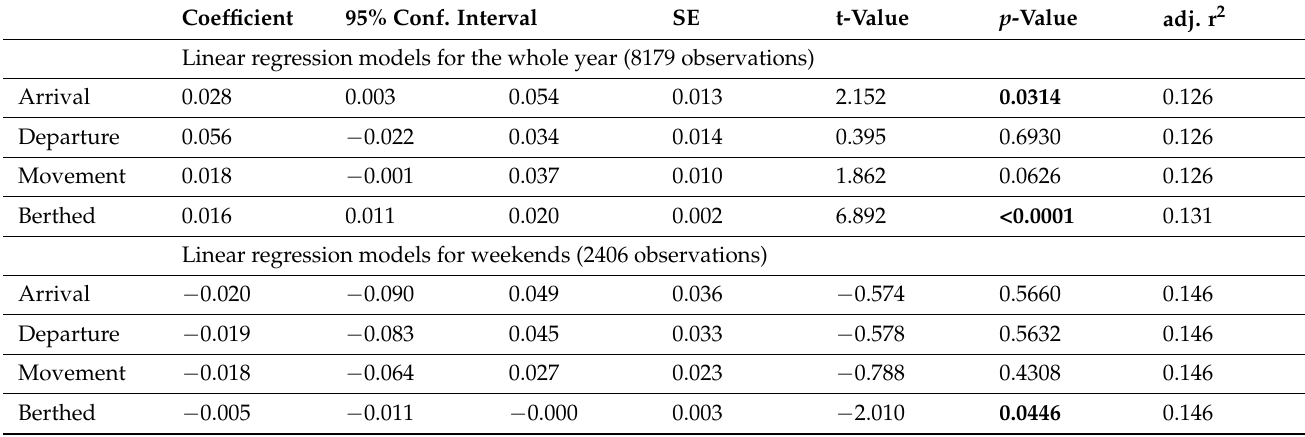
Table 5. Multivariable linear regression analysis results for vessel arrivals, departures, movement and laying alongside to the logarithm of PM 2.5 hourly mean concentrations controlled for wind direction,